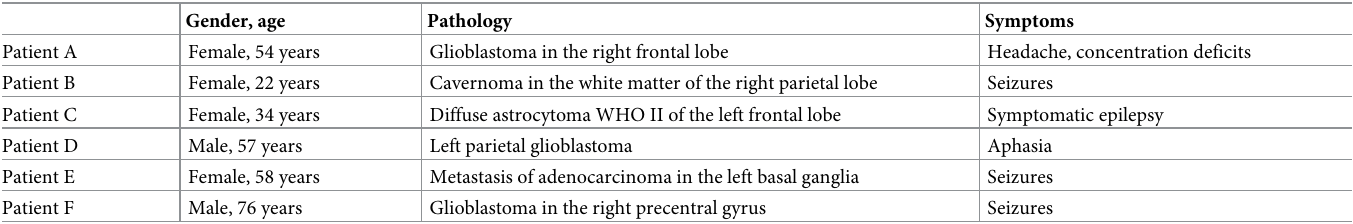
Table 1. List of patients used for the study and their pathologies and symptoms. Gender,